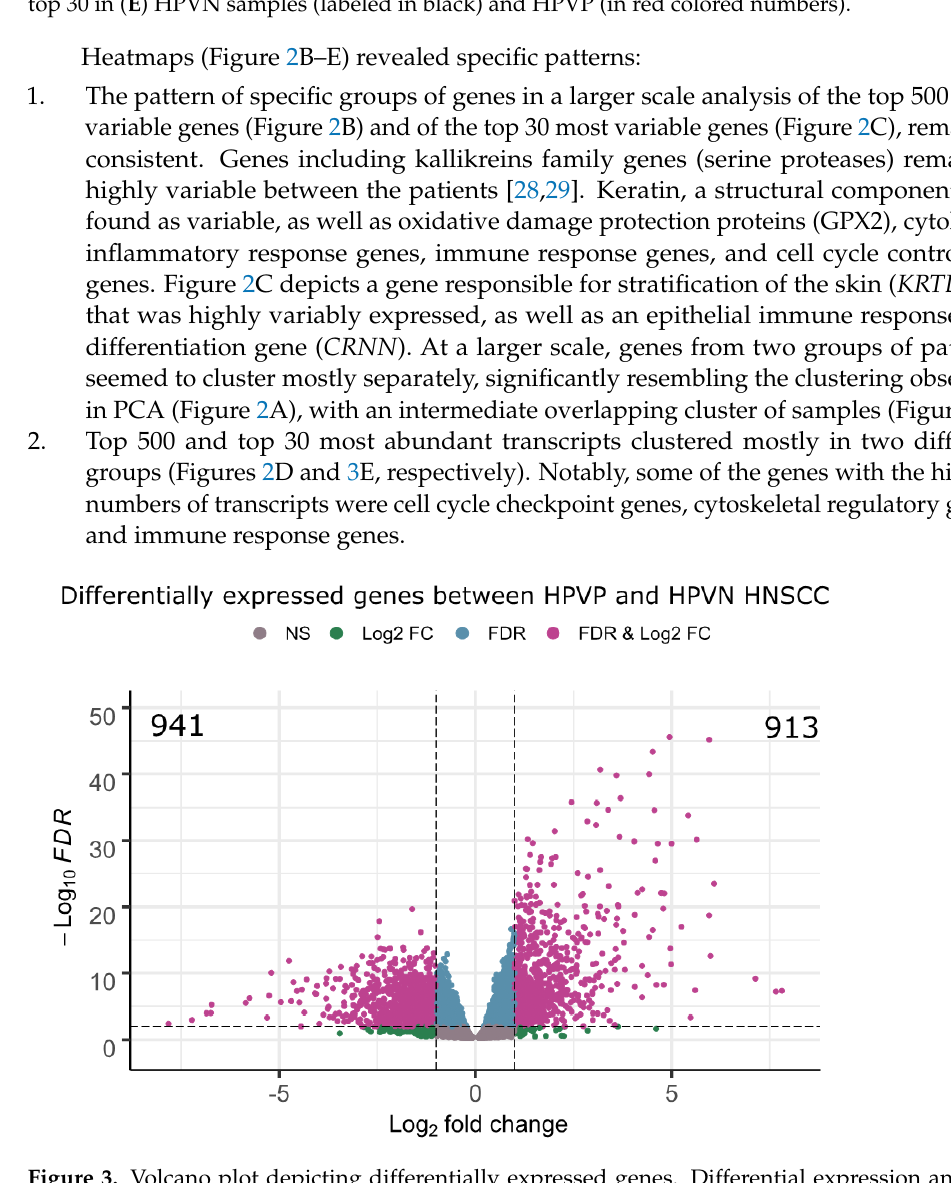
Figure 3. Volcano plot depicting differentially expressed genes. Differential expression analysis identified 1854 DEGs, 941 were downregulated and 913 were upregulated between HPVP and HPVN HNSCC patient groups (using HPVN as a baseline for comparison). Purple represents DEGs, blue is statistically significant according to the p -value, green is statistically significant according to the logFC, while grey is not statistically significant.